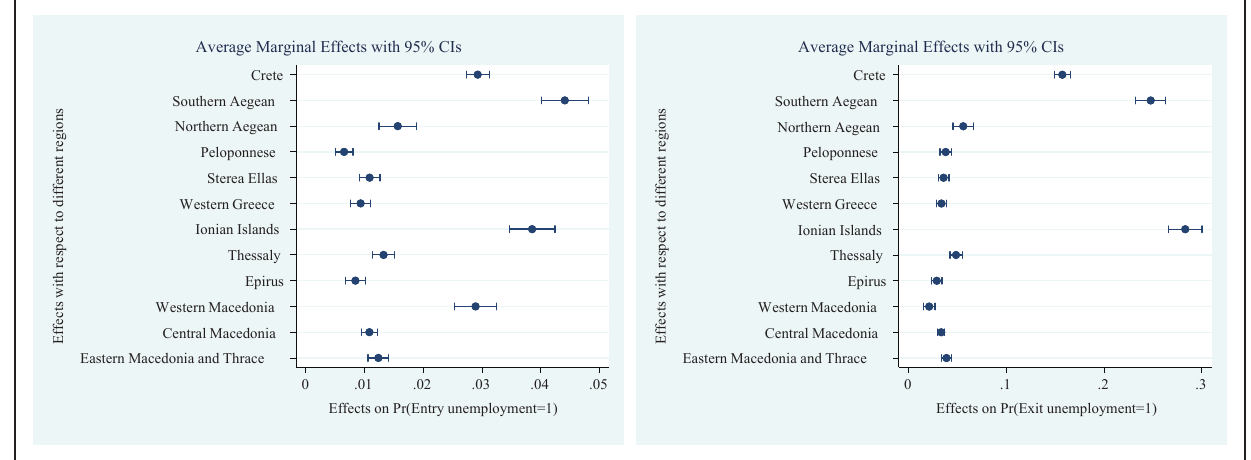
Average marginal effects of entering and exiting unemployment for different regions (total